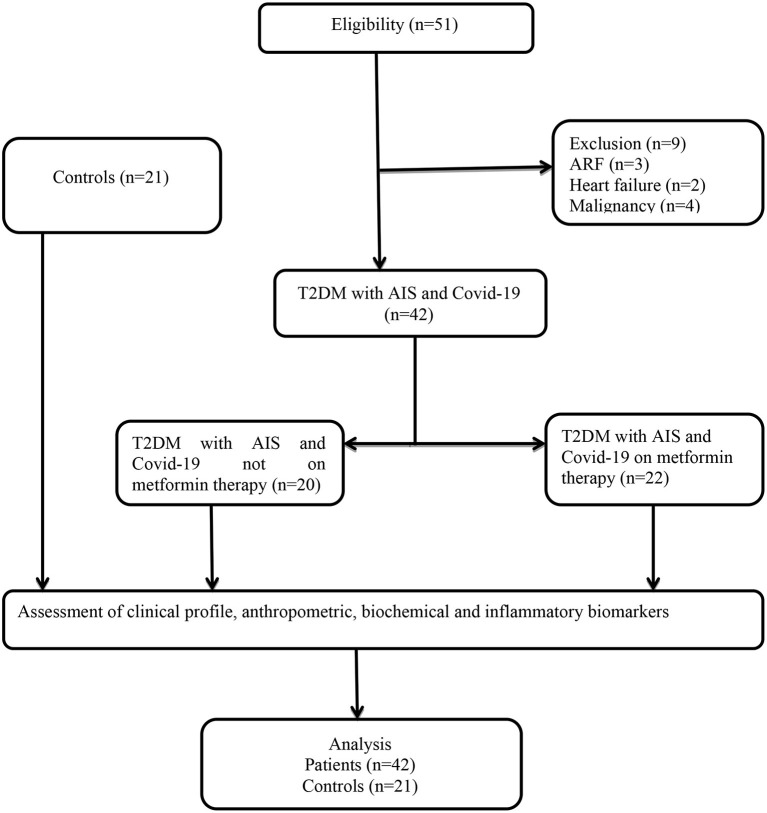
Consort-flow chart of the study.